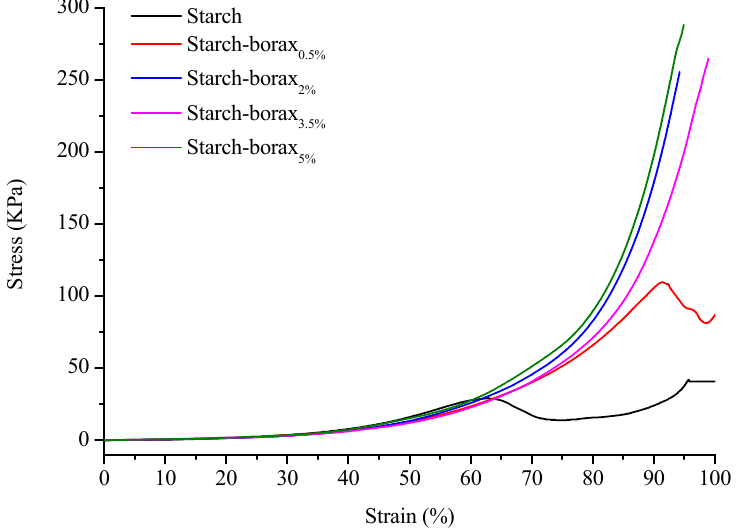
Figure 5. Compressive stress–strain curves of normal corn starch hydrogel and starch–borax DC hydrogels with different content levels of borax.